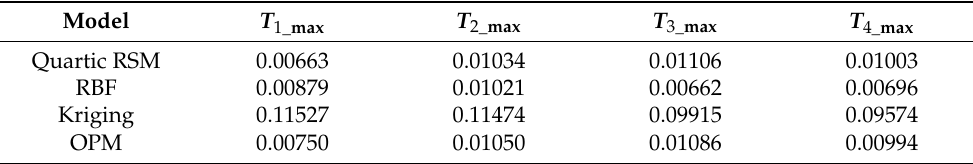
Table 5. R-square error of each surrogate model.